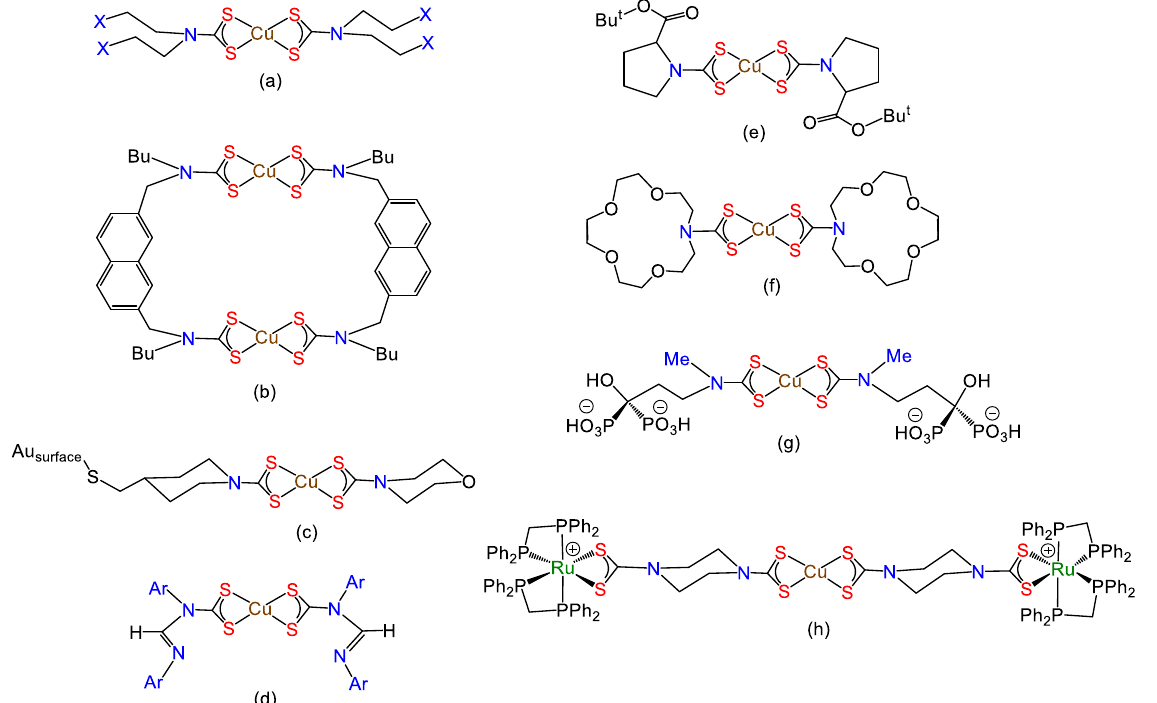
Figure 2. Examples of novel Cu(II) bis(dithiocarbamate) complexes ( a ) – ( h